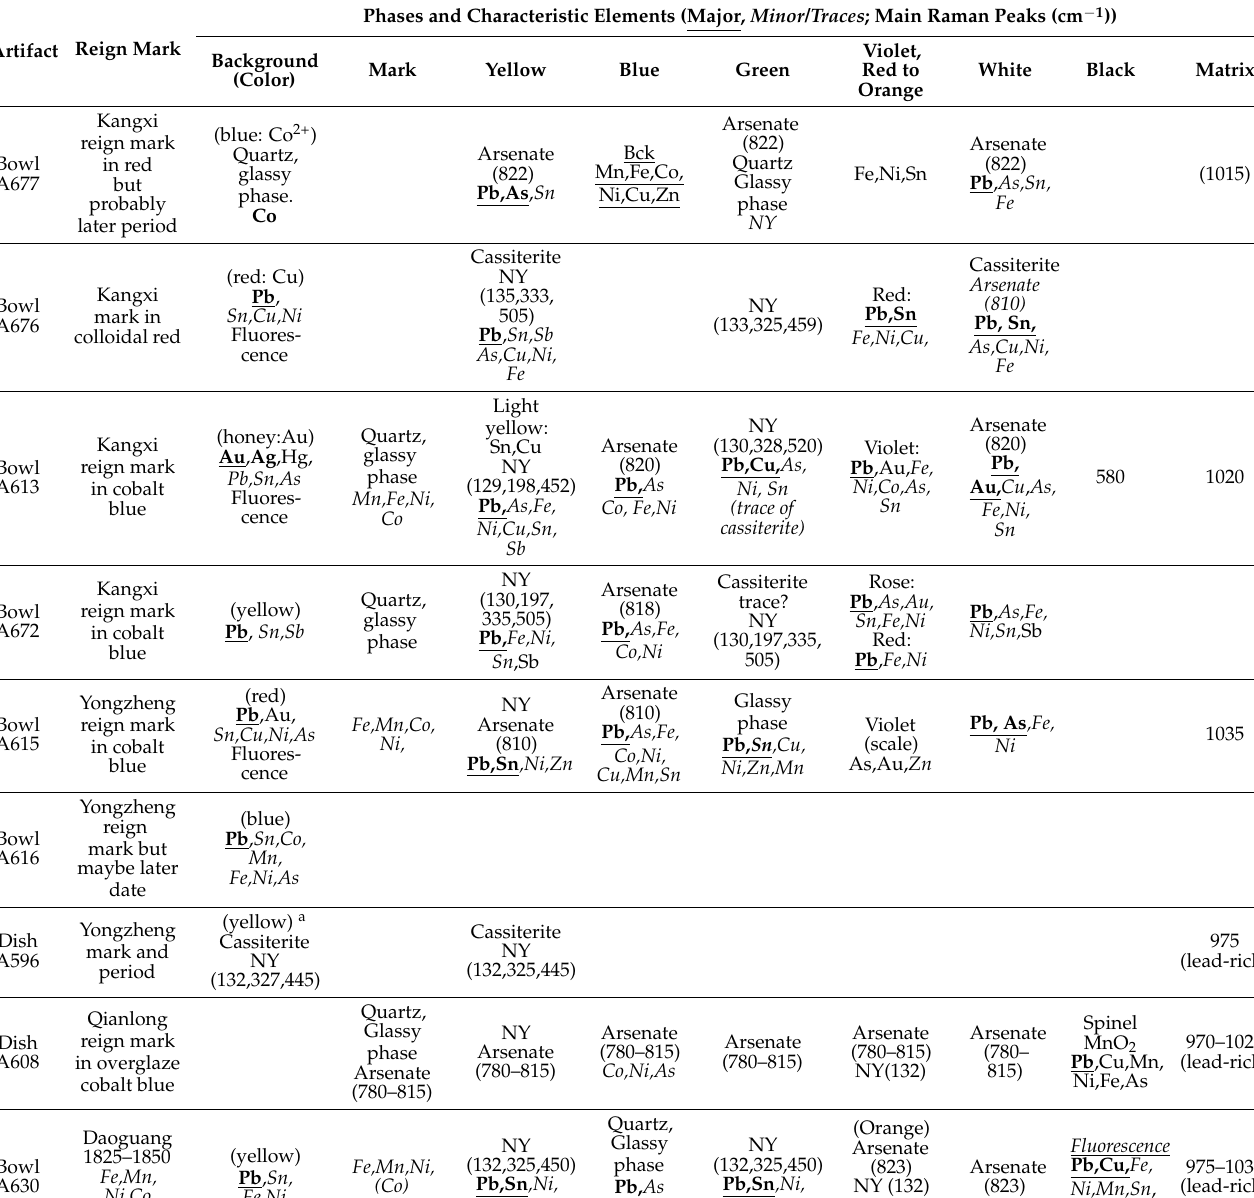
Table 2. Phases and elements detected (major elements in bold, underlined; NY: Naples